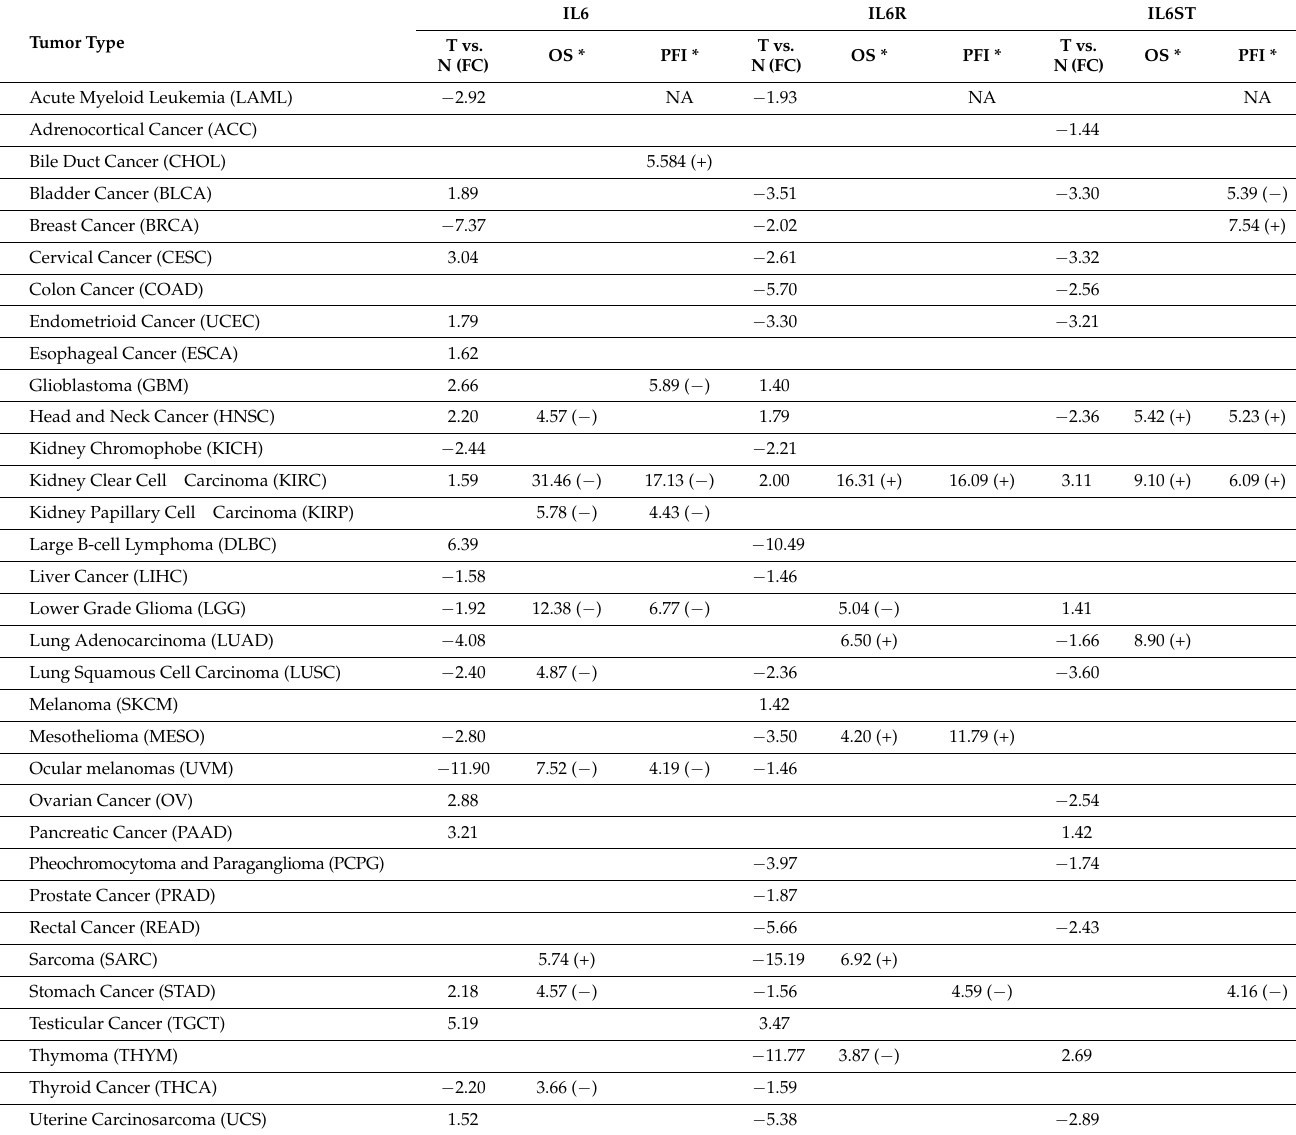
for all TCGA tumors, indicating that Exon 9 skipping was a sporadic event (Figure S3). Table 1. Gene expression of IL6, IL6R, and IL6ST and survival analysis in all tumor types. Tumor